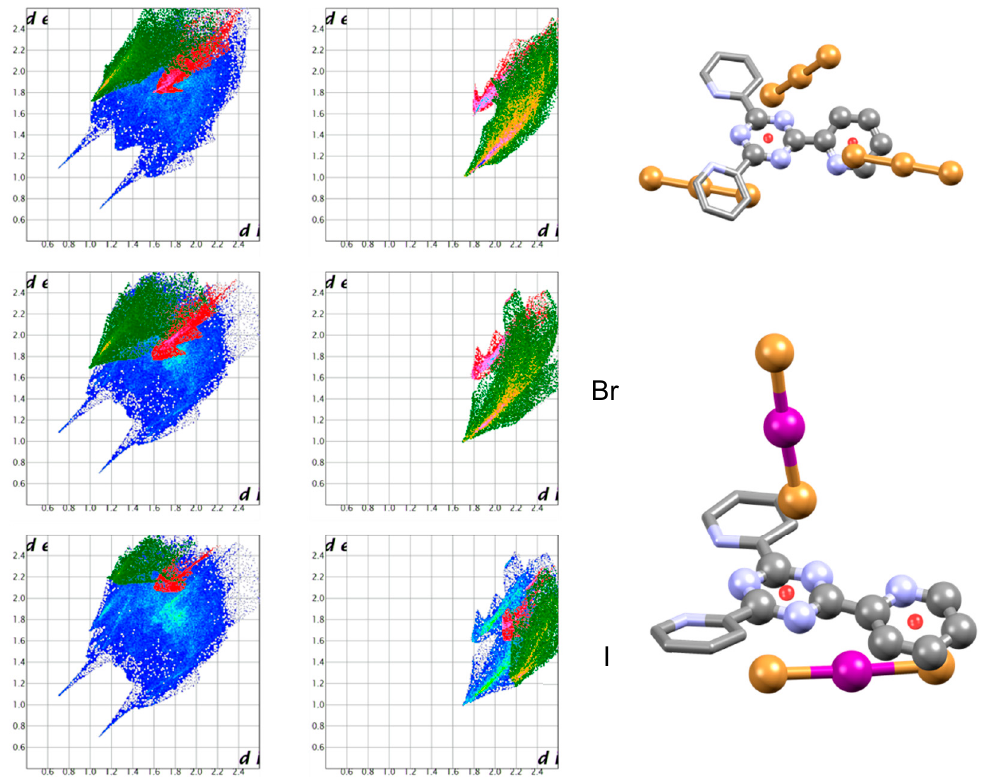
Figure 13. Complexes of the monoprotonated 2,4,6-tris(2-pyridyl)-1,3,5-triazine ligand with Br 3 −